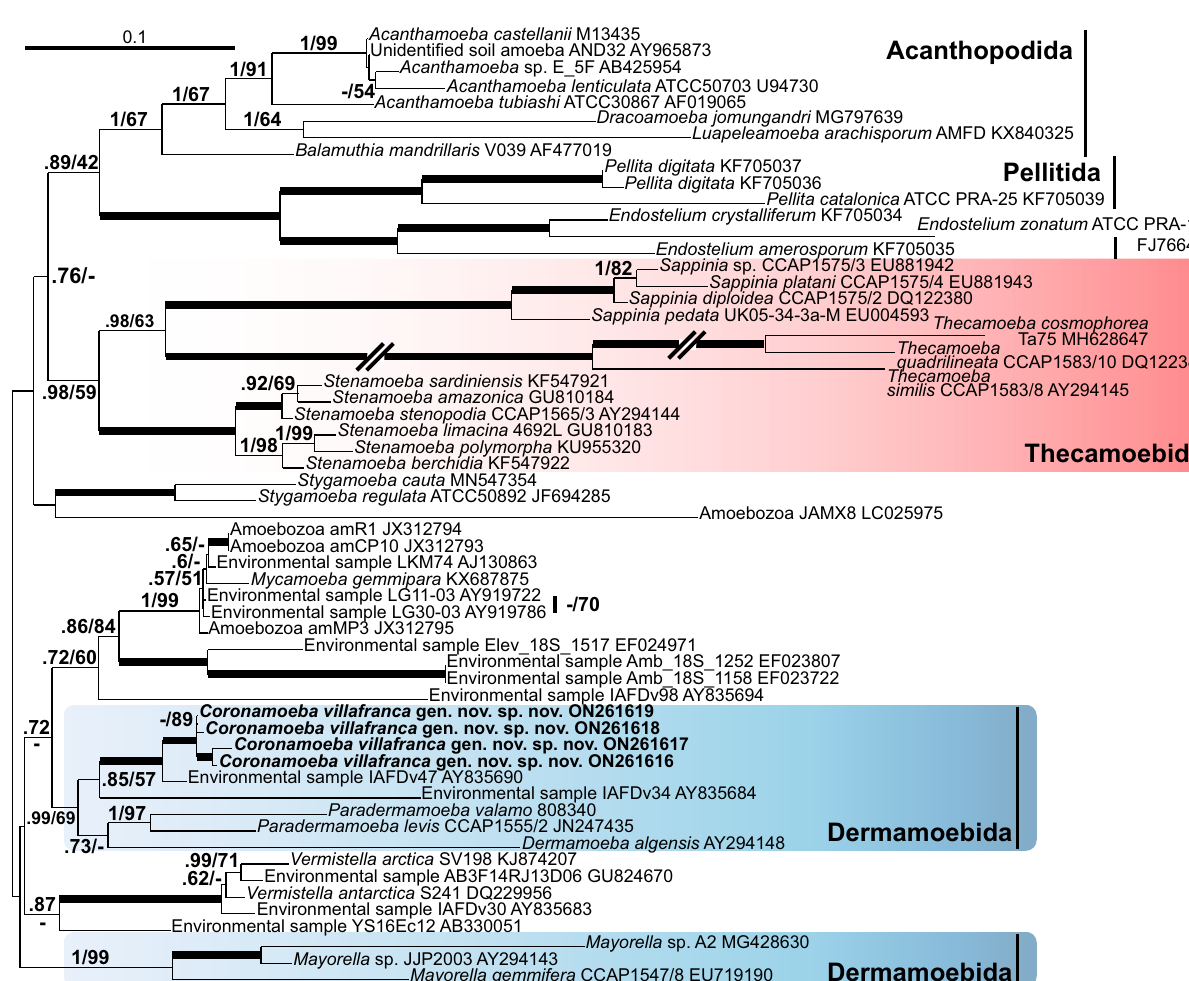
Figure 4. Part of the maximum likelihood phylogenetic tree based on the SSU rRNA gene analysis showing position of Coronamoeba villafranca gen. nov. sp. nov. (indicated in bold) among Dermamoebida and related clades. Numbers at nodes indicate posterior probabilities/bootstrap support values if above 0.5/50. Thick branches = 1/100. Scale bar 0.1